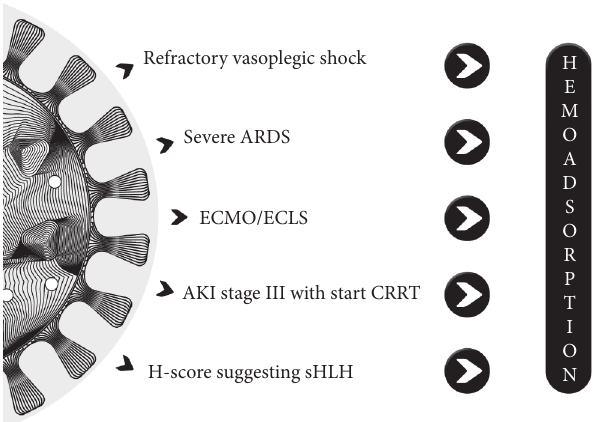
Figure 1: Potential indications for hemoadsorption in COVID-19 patients. ARDS, acute respiratory distress syndrome; ECMO/ECLS, extracorporeal membrane oxygenation/extracorporeal life support; CRRT, continuous renal replacement therapy; HLH, hemopha- gocytic